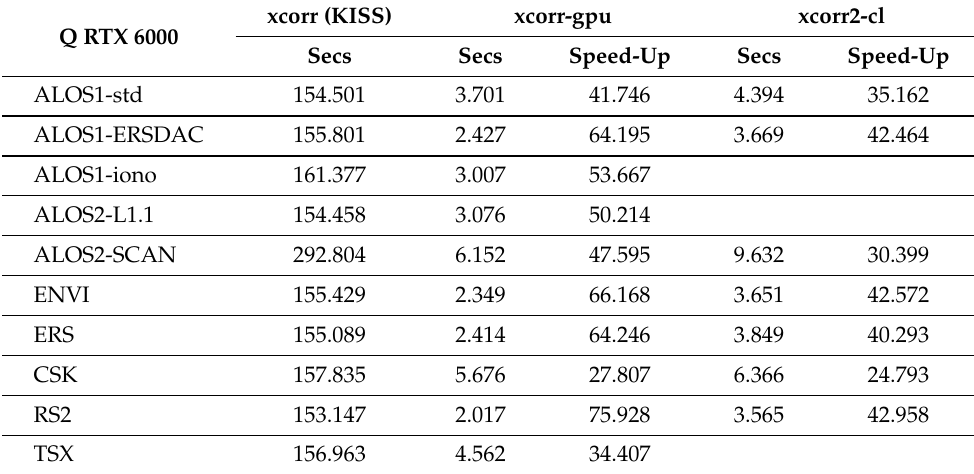
Table 5. Execution times and Speed-Up for xcorr , xcorr-gpu , xcorr2-cl on Q RTX 6000 hardware config-